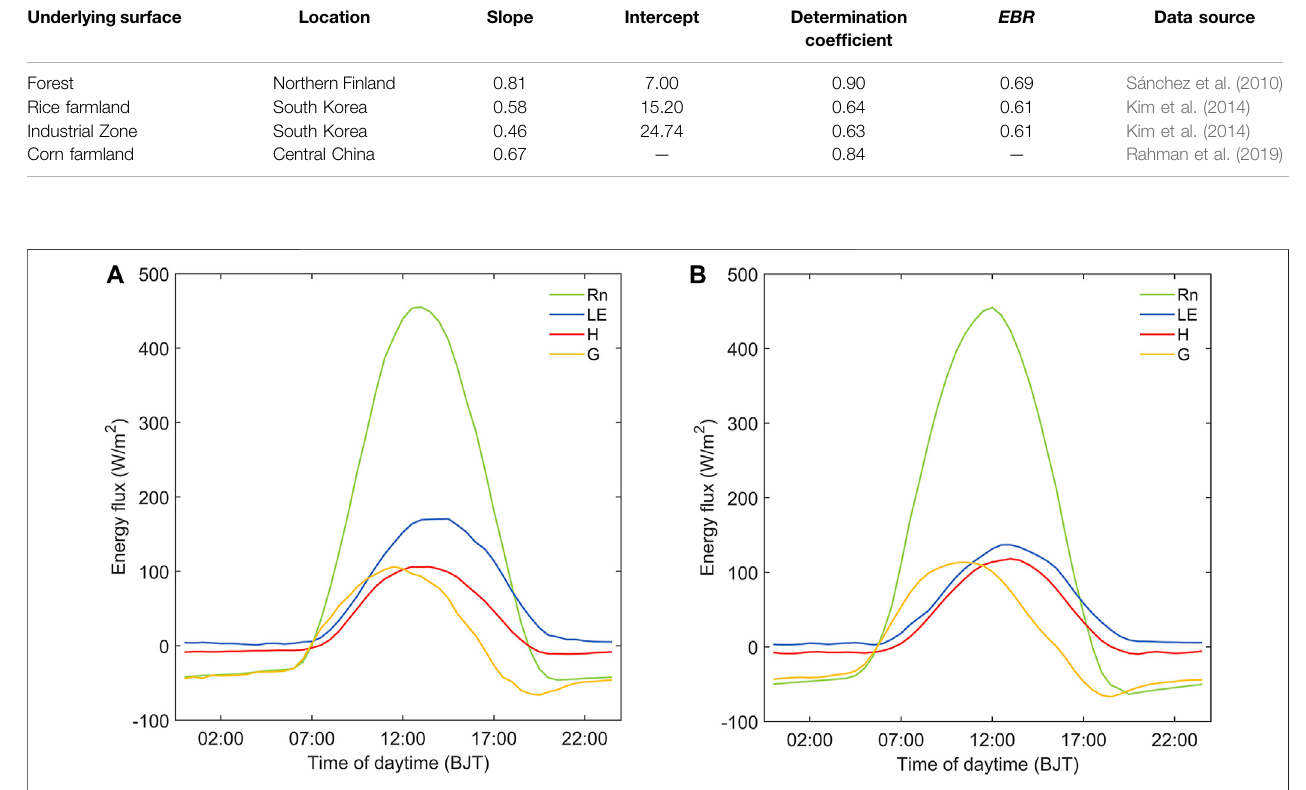
FIGURE5| Averagediurnalvariationinmainenergycomponentsinthe (A) westernand (B) easternregionsofthetransitionzonefromJulytoSeptember. R n isthe net radiation, LE is the latent heat fl ux, H is the sensible heat fl ux, and G is the soil heat fl ux. Times are in Beijing Time Research on the impact of vegetation change on land-atmosphere coupling strength in northwest China (BJT).